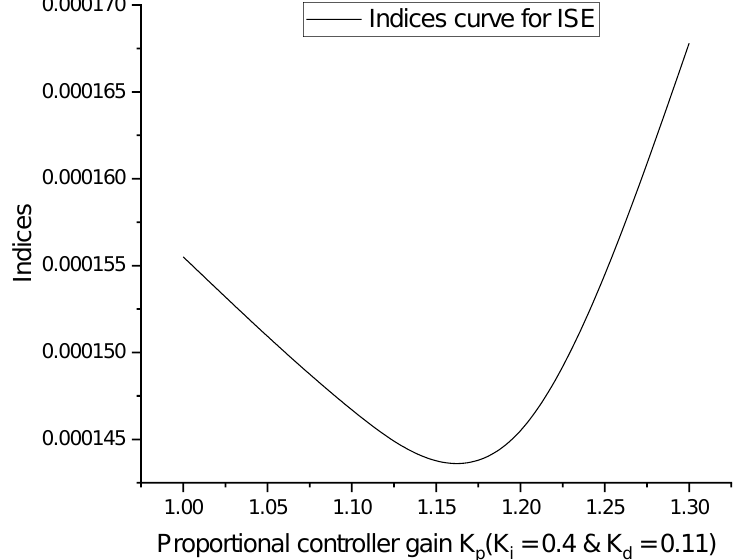
Figure 3. ISE performance indices curve.